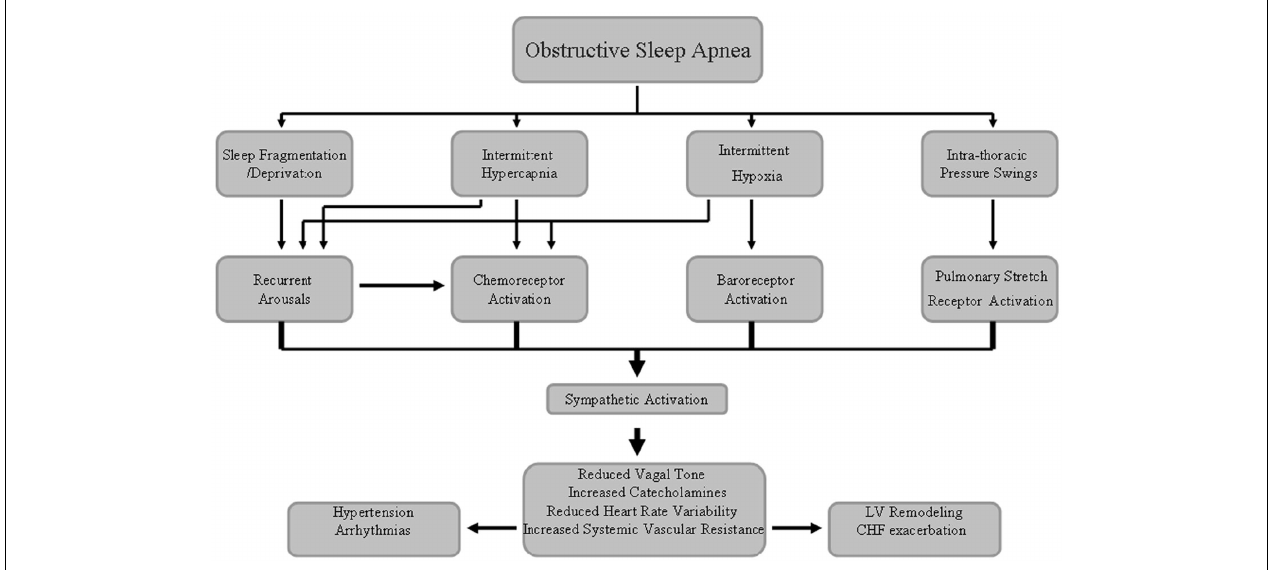
FIGURE 1 | Schematic diagram underlying the sympathetic nerve system activation associated with obstructive sleep apnea syndrome that may lead to increased cardiovascular disease risk.